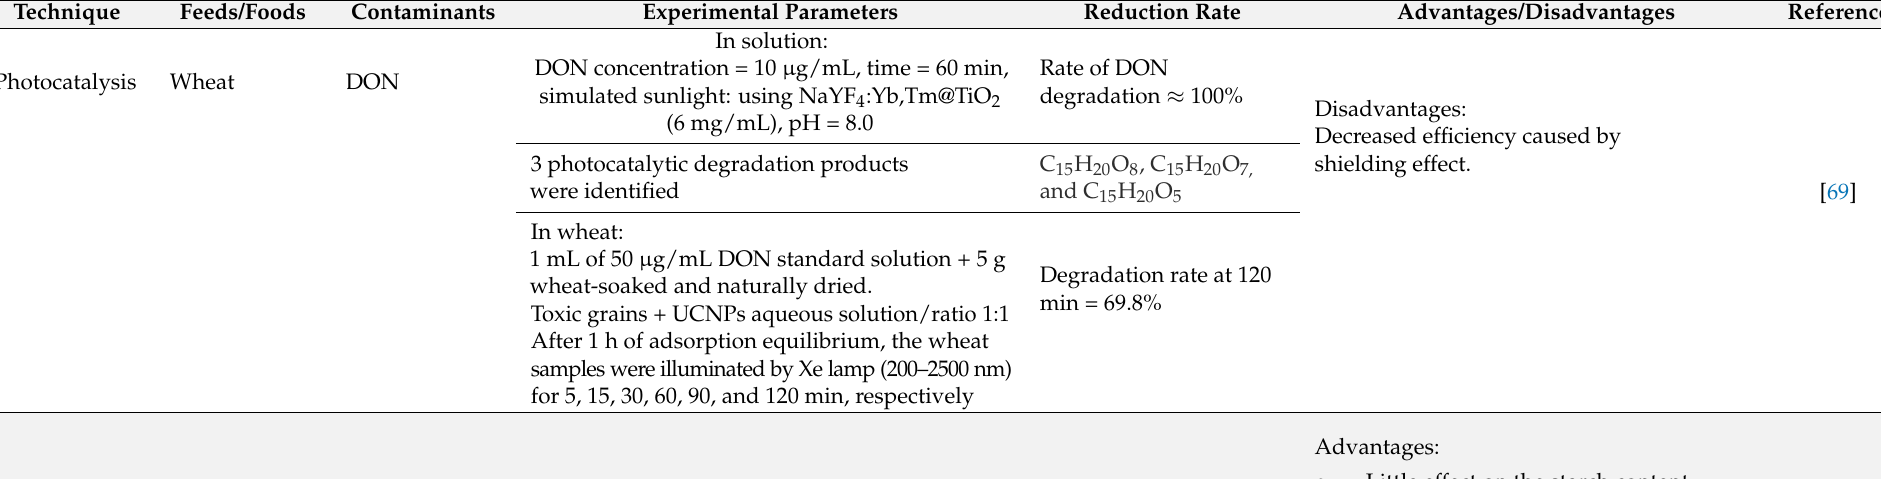
Table 2. Physical treatments for the reduction of mycotoxins in solid foods and